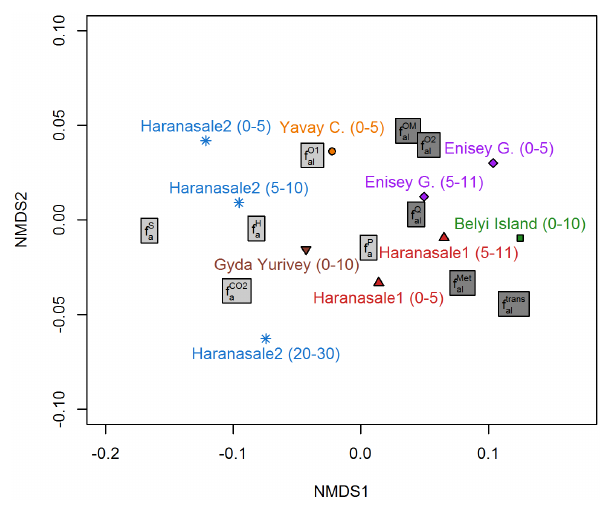
Figure 6. Non-metric multidimensional scaling (NMDS) analy- sis of humic acids based on their carbon functional groups, de- rived from 13 C-NMR spectral integration. Dark-grey and light-grey groups indicate aliphatic and aromatic carbon structures, respec- tively. Carbon functional group symbols are specified in Sect. 4.3. Numbers in parentheses indicate the sampled soil depth in centime-